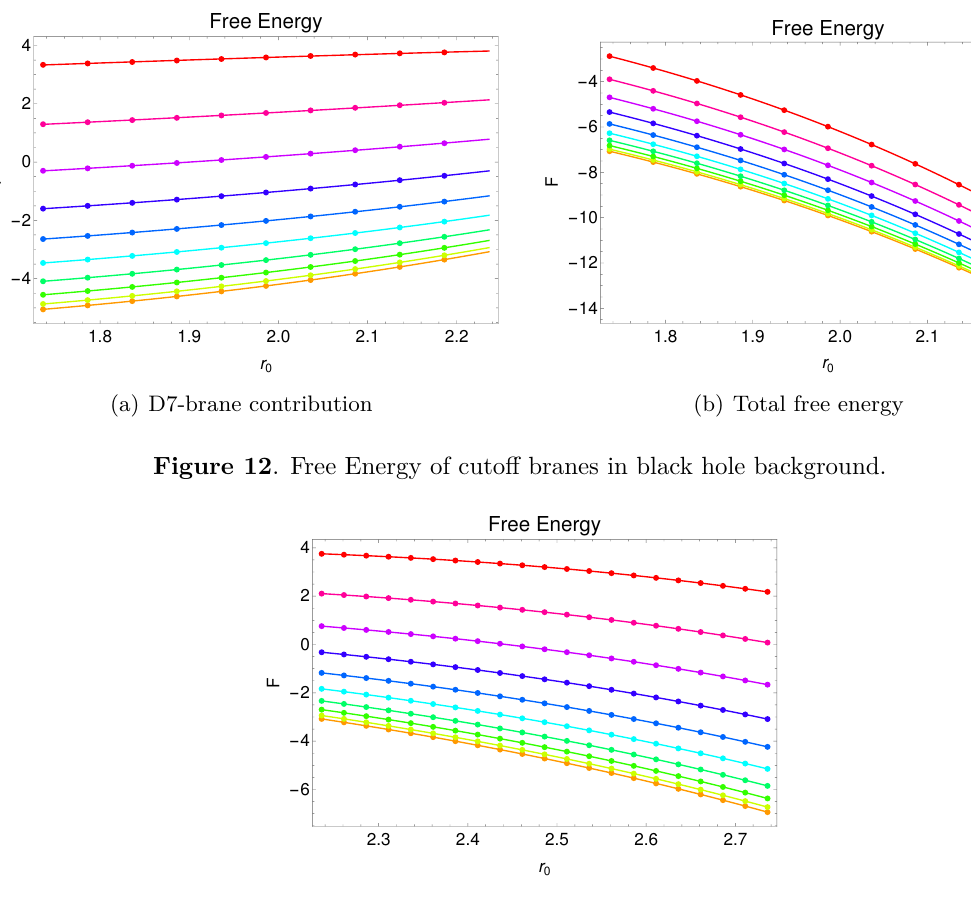
Figure 13 . The free energy of D7-branes ending on the